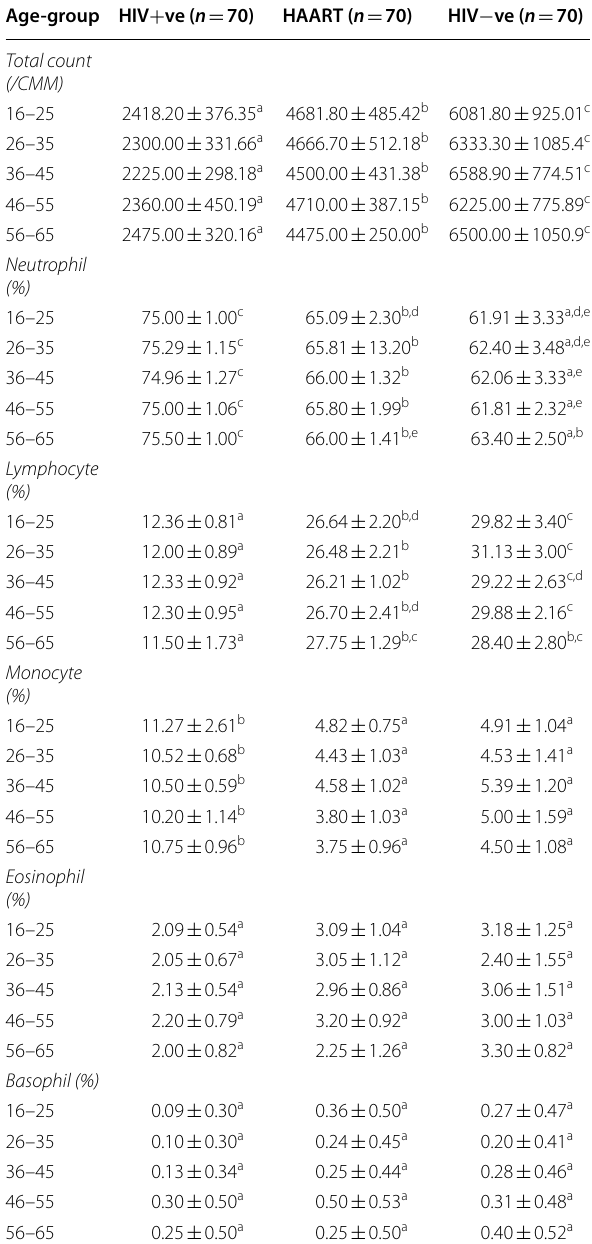
Table 1 Hematologic parameters of HIV-positive patients, HIV-positive patients on antiretroviral drugs and HIV-negative subjects